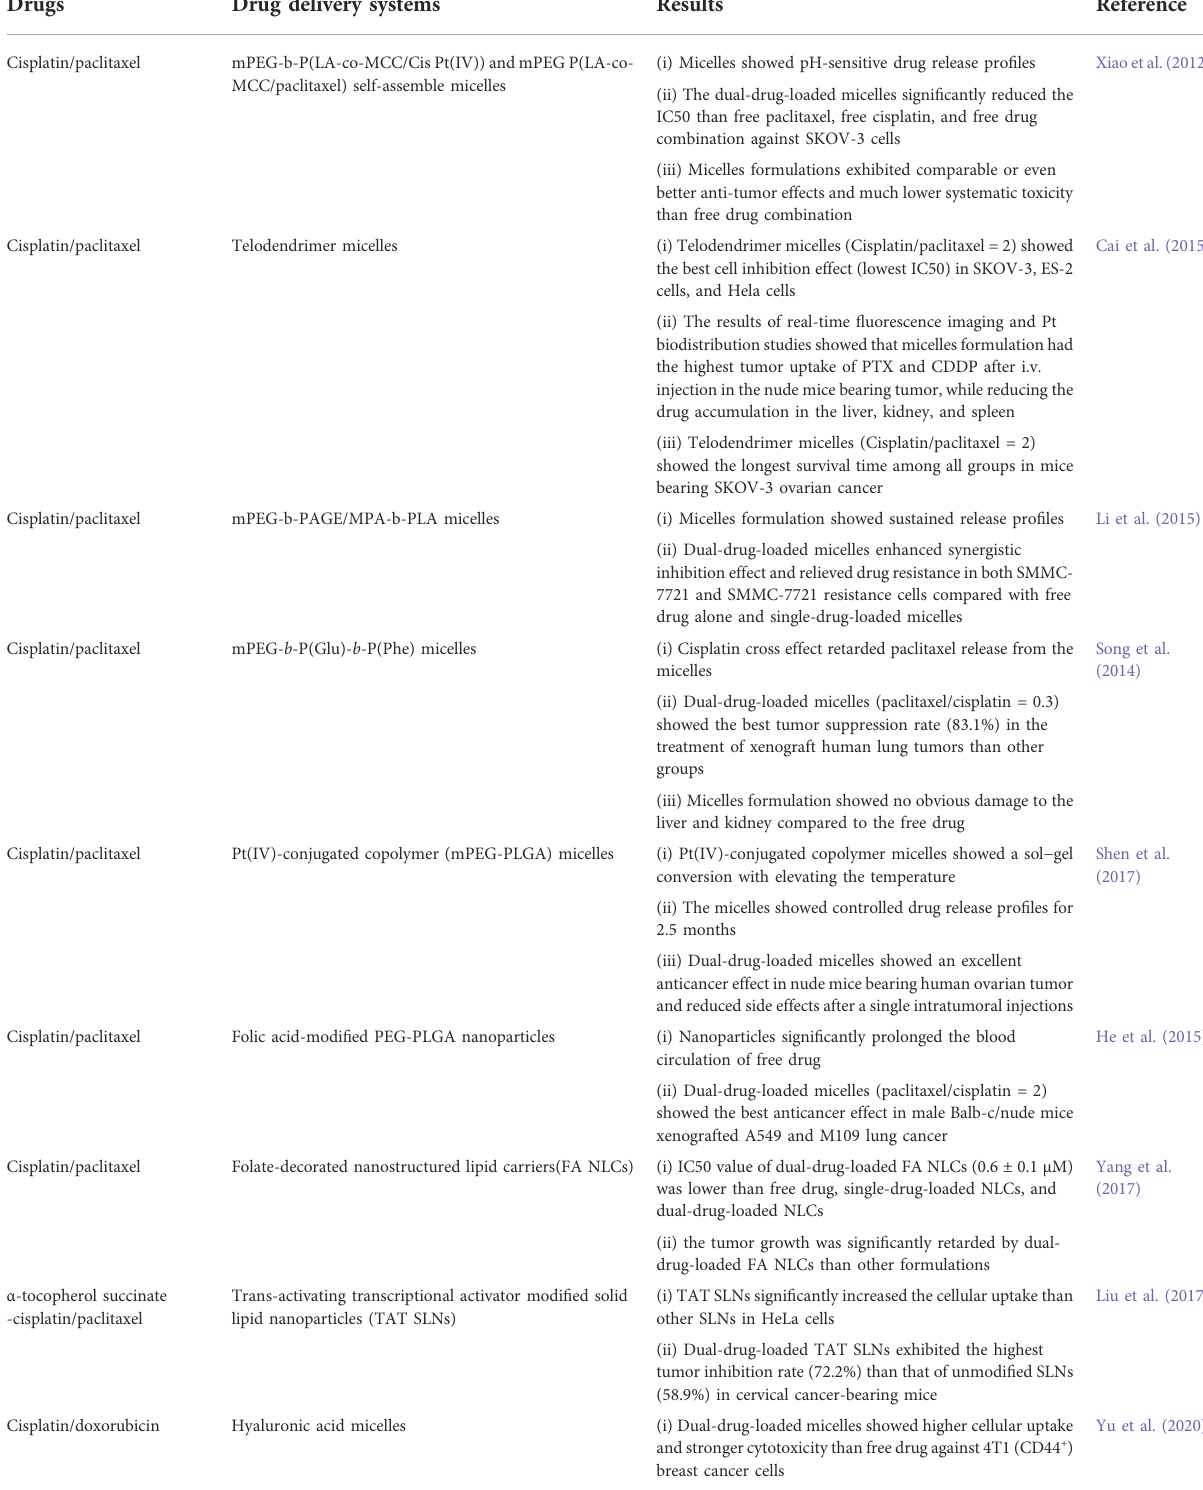
TABLE 1 Recent advances in nanocarriers containing platinum compounds and other drugs for combination